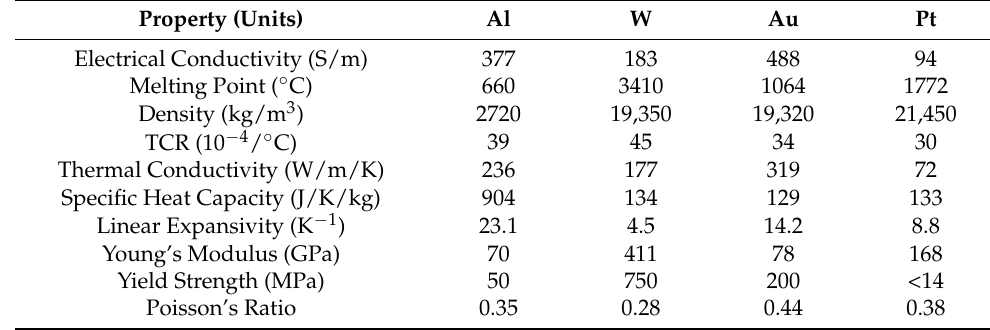
Table 4. Comparison between the materials that are commonly used for the metal layer within CMOS MEMS sensors (as part of the CMOS sequence or post-CMOS), and thus used frequently for the heated